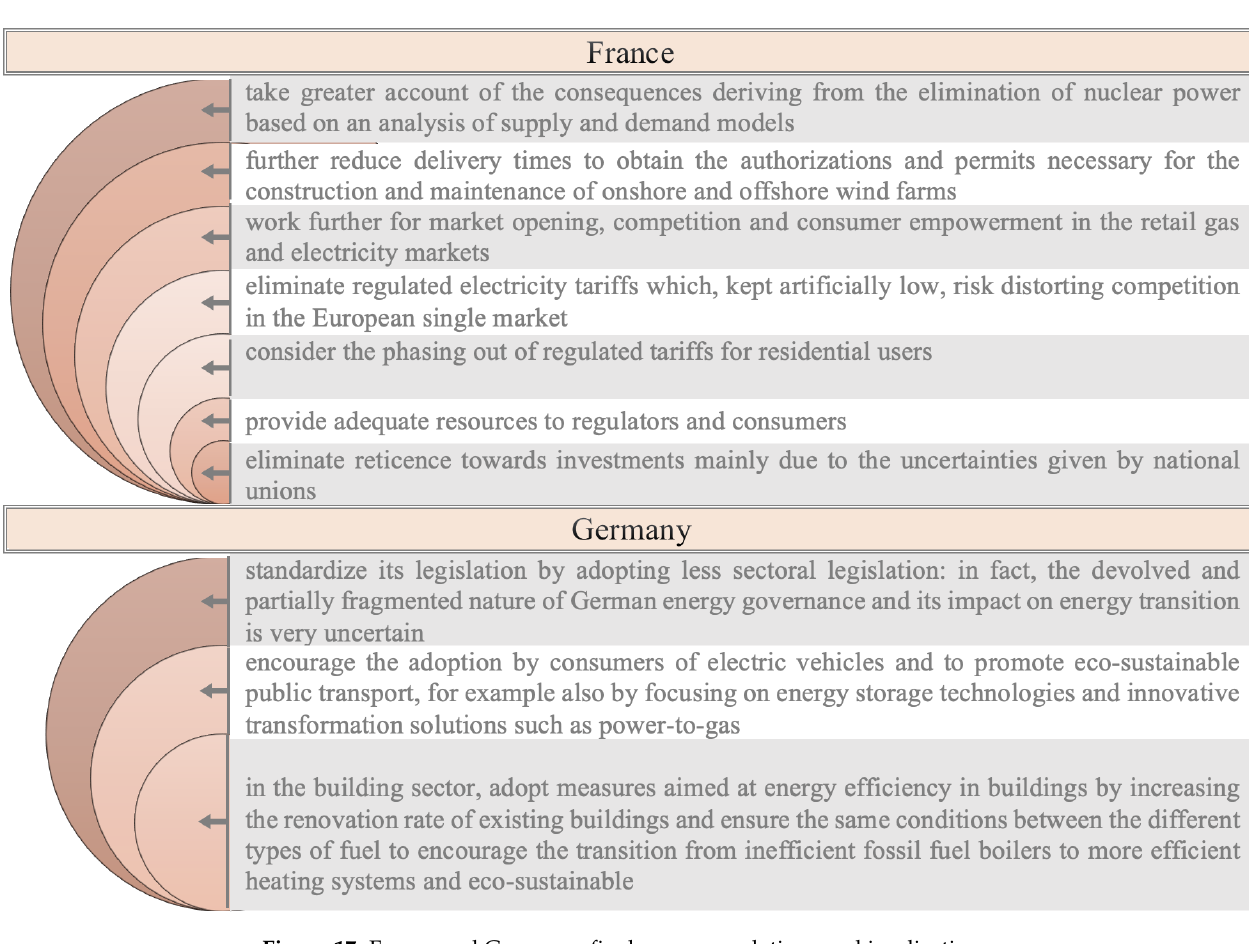
Figure 17. France and Germany: final recommendations and implications.